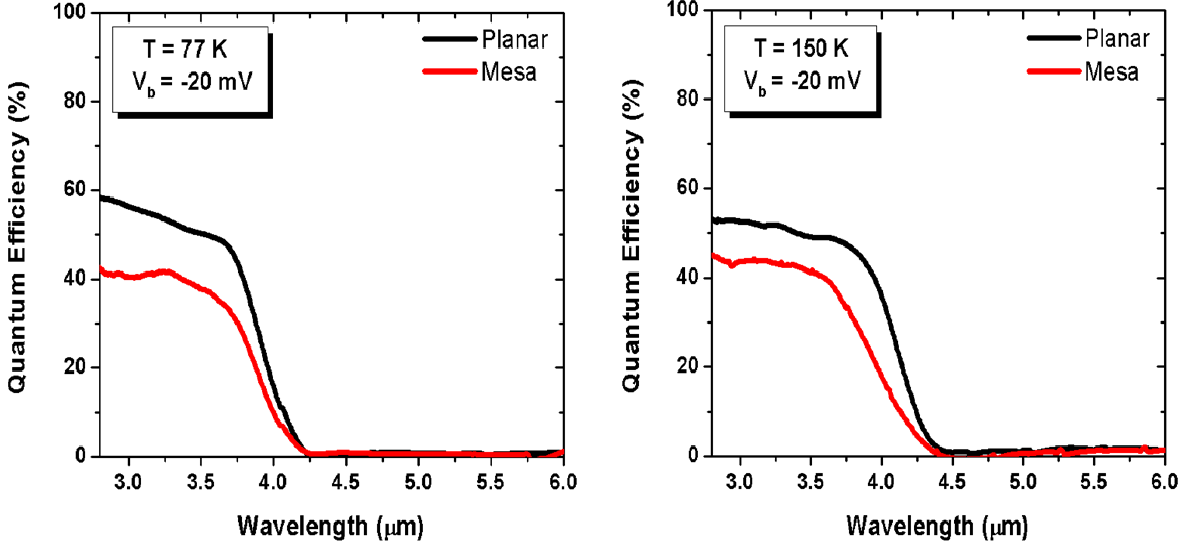
Figure 4. The comparison between the quantum efficiency spectra of the T2SL planar photodetector and mesa-isolated photodetector under − 20 mV at 77 K ( left ) and 150 K ( right ).